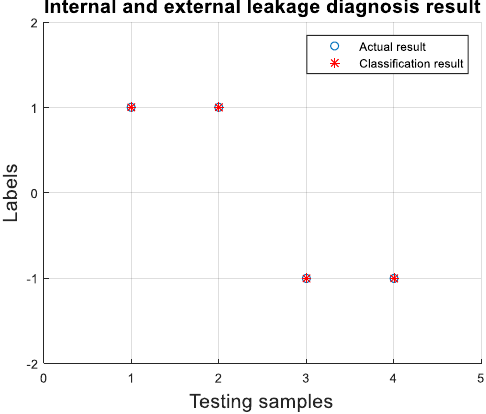
Figure 7. Relay valve internal and external leakage diagnosis result.